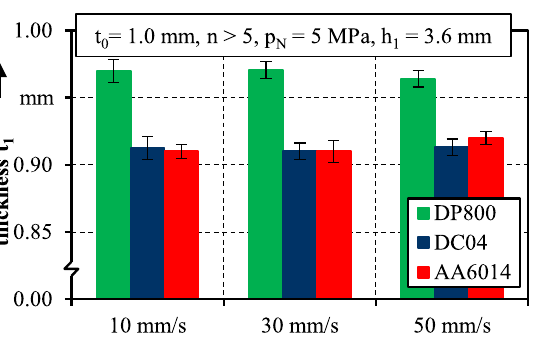
Fig. 3. Strip thickness after drawbead passage with h 1 =3.6 mm, a constant blankholder pressure p N = 5MPa and variation of drawing velocity between v =10 mm/s and 50mm/s.